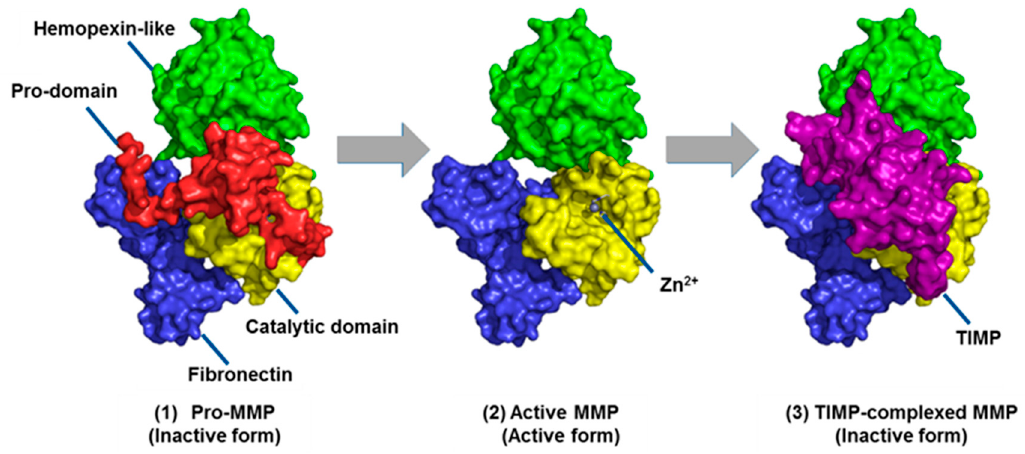
Figure 1. Three forms of matrix metalloproteinases (MMPs), as demonstrated for MMP-2: inactive zymogen (pro-MMP), active MMP, and inactive tissue inhibitor of metalloproteinases (TIMP)-complexed MMP. Cleavage of the prodomain (red) allows access to the catalytic site, while TIMPs block access to inactivate the MMP. Reproduced from Nguyen et al. [13].